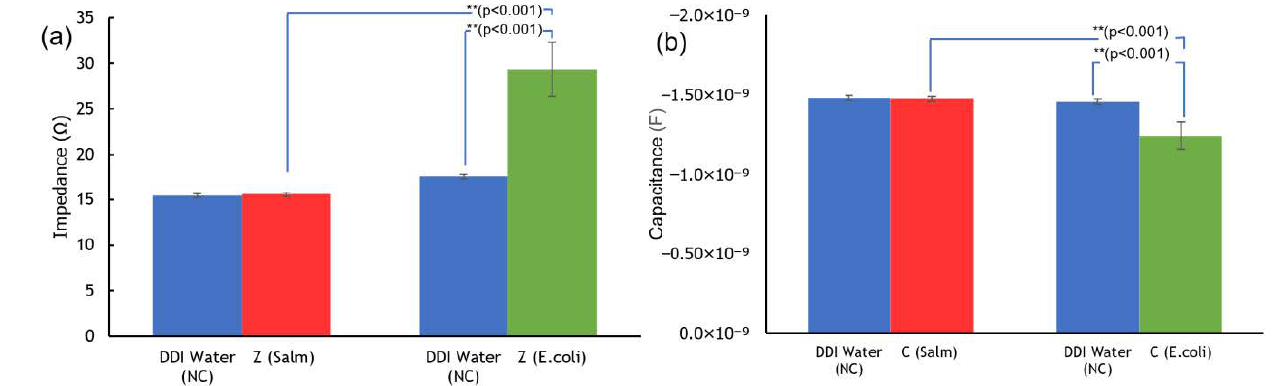
Figure 7. Mean value of the ( a ) impedance and ( b ) capacitance measurement data of E. coli , Salmonella , and their NC at the characteristic frequency of 7.69 MHz. Remarks: ** significant at p < 0.001.